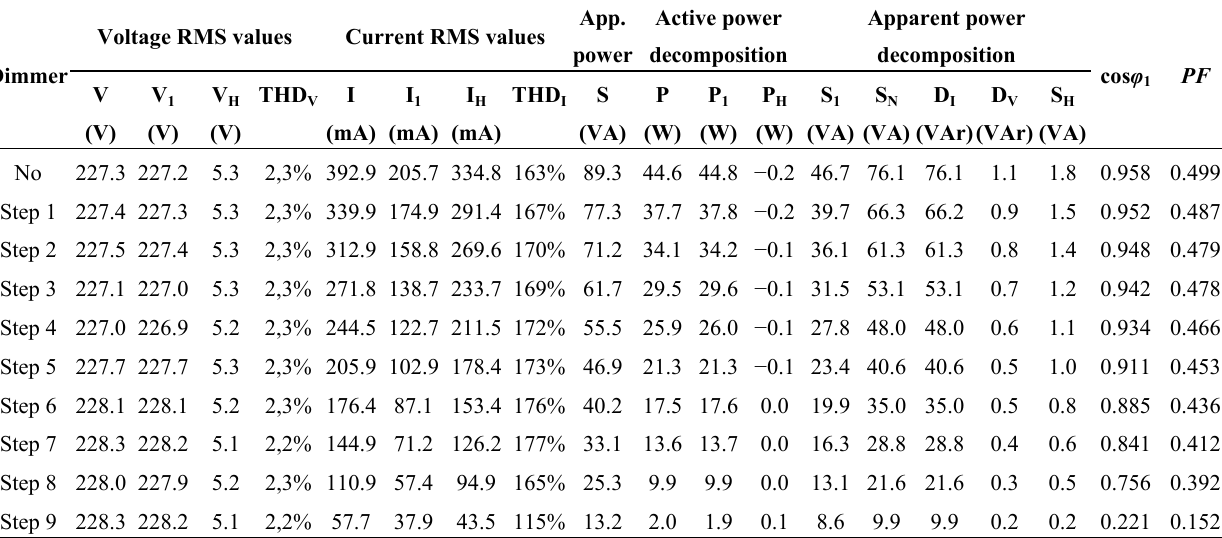
Table 2. Power quality analysis of the measurements results for 49.5 W LED panel with 60 W ballast.